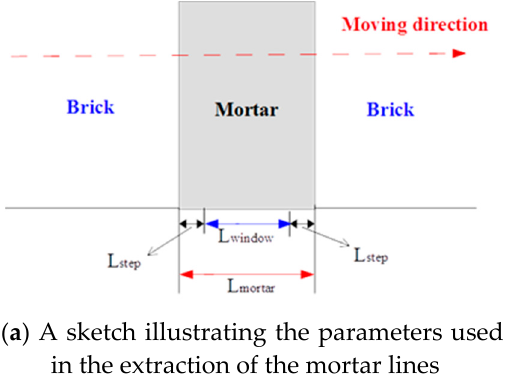
Figure 6. Automatic virtual point extraction.